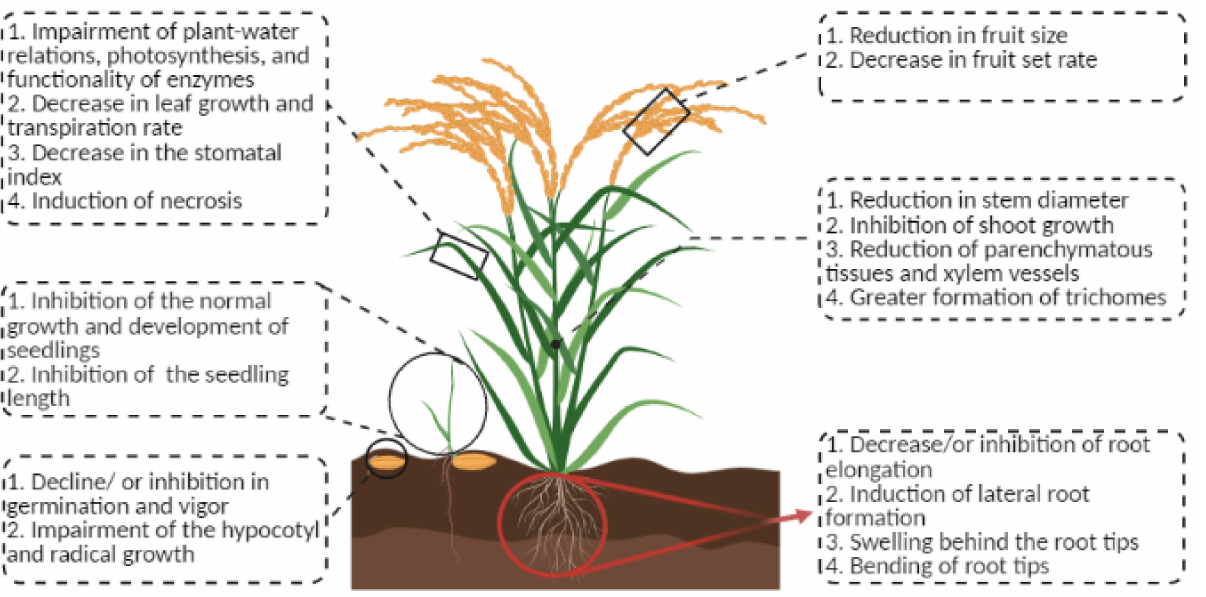
Figure 1. Image depicting the heavy metal (HM) toxicity-induced morphological, anatomical, and physiological changes in the